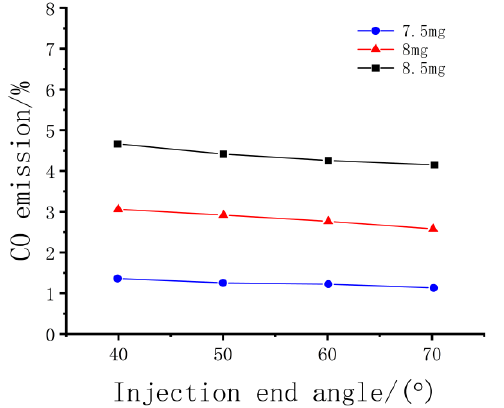
Figure 35. Effect of the injection parameters on CO emissions.